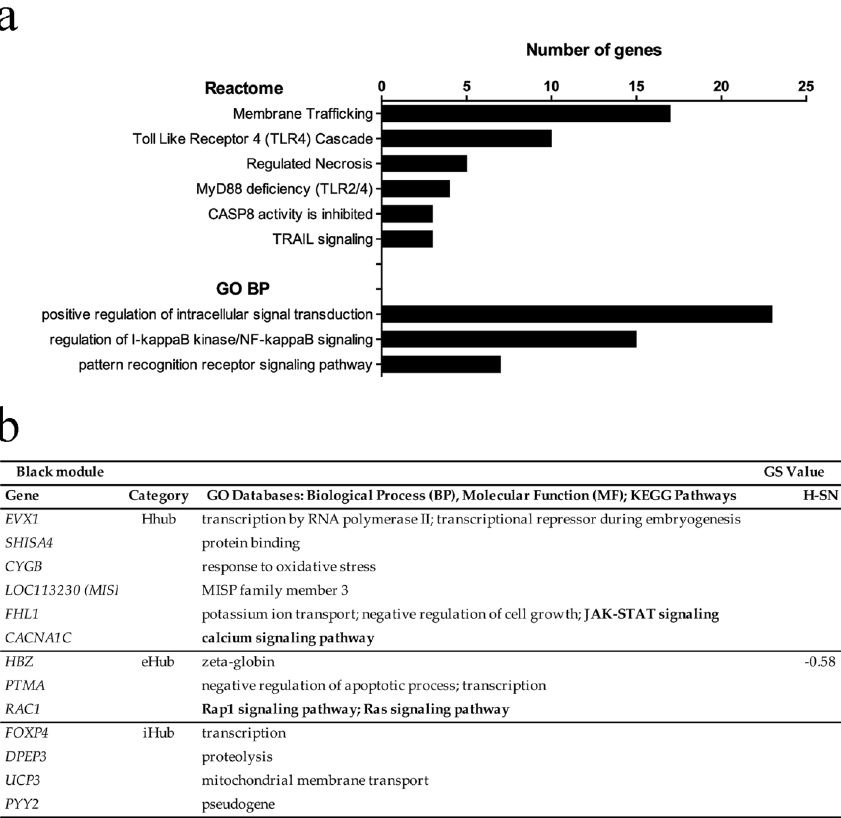
Figure 4. Enrichment analysis and high hierarchy genes (HH genes) for the black module. ( a ) Histogram of enriched Reactome and GO BP terms. The terms with adjusted p < 0.05 were considered significant. ( b ) HH genes (Hhubs, iHubs, and eHubs) of this module, which is significantly and positively correlated with subgroup A and with H-SN traits. Each HH gene is identified by its hierarchical categorization, GO biological process or molecular function, and KEGG Pathways-related terms (in bold letters). Only positive (i.e., hyper-expressed) or negative (i.e, hypo-expressed) significant GS values for the specific trait ( p < 0.01) are shown. H‑SN high per- centage of segmented neutrophils in the hemogram, GS gene